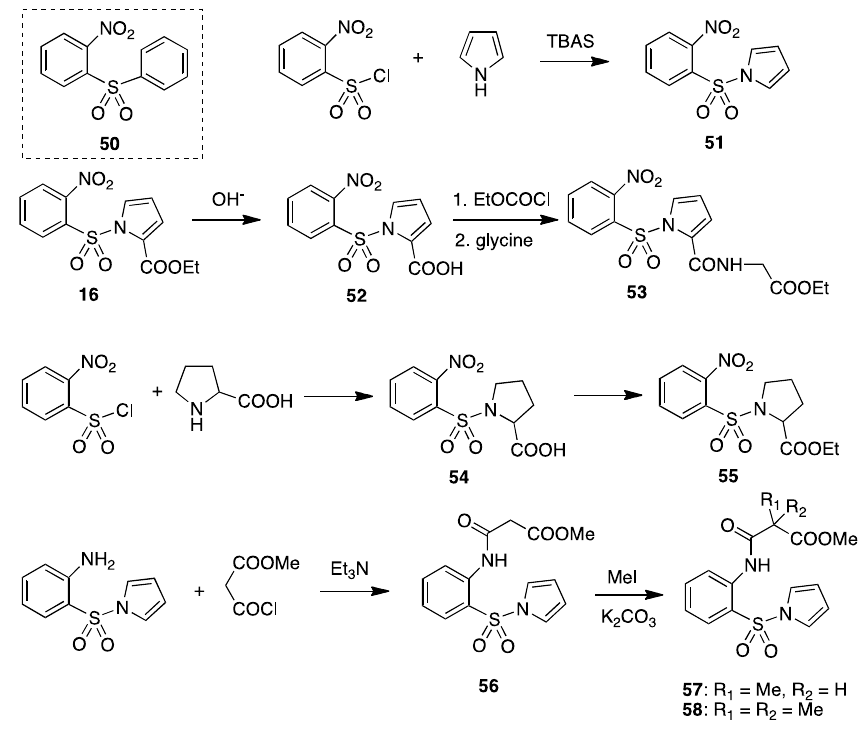
Table 4. Anti-HIV-1 Activity of PASs 16 and 51 – 58 a .